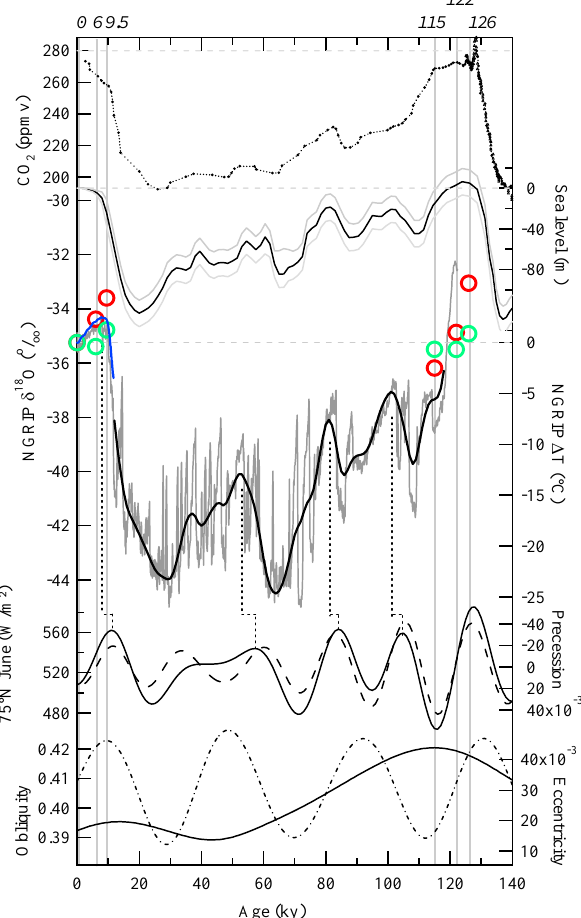
Fig. 1. From top to bottom: black dots, atmospheric CO 2 concen- tration (Vostok and EDC ice cores) on the EDC3 age scale (Barnola et al., 1987; Lourantou et al., 2010); solid black line with uncer- tainties, estimation of eustatic sea level (Waelbroeck et al., 2002); NorthGRIP ice core δ 18 O data on a 20 year resolution on GICC05 and EDC3 age scale (Capron et al., 2010a). The orbital component of the record is displayed (thick black line) and was calculated using the first three components of a singular spectrum analysis. A tenta- tive estimate of the temperature change is also displayed, following Masson-Delmotte et al. (2005b) (right axis). The reconstruction of the Holocene Greenland temperature (at fixed elevation) (Vinther et al., 2009) is displayed as a bold blue line. Summer (red) and annual mean (green) temperature anomalies simulated by the IPSL model are displayed as open circles for 6, 9.5, 115, 122, and 126ka. The 75 ◦ N June insolation (black line, Wm − 2 ) and orbital parameters (precession parameter – long dashed line, obliquity – short dashed line, and eccentricity – solid black line) are displayed in the two lowest